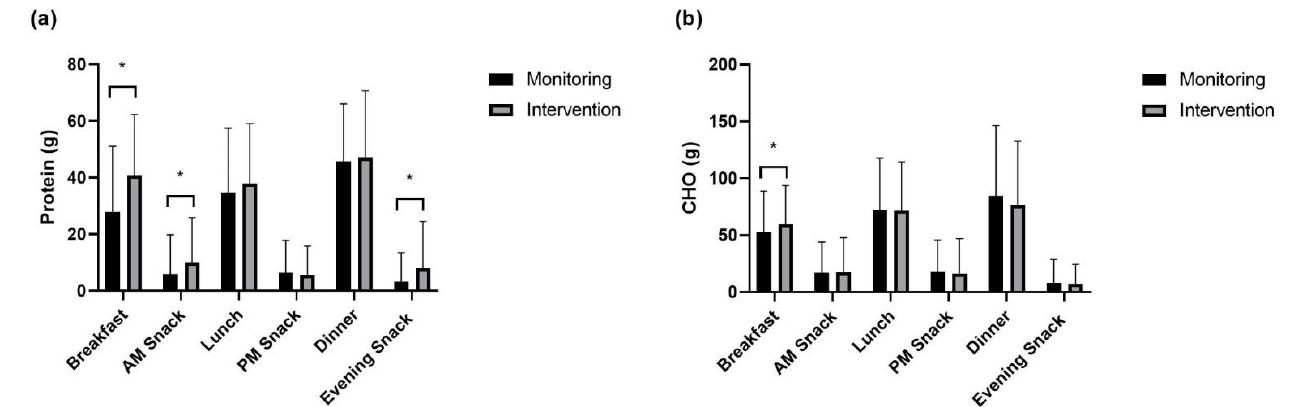
Figure 1. Absolute between-meal intake on low-volume training days of ( a ) protein and ( b ) carbohydrate. * signifies a difference in intake between monitoring and intervention periods.